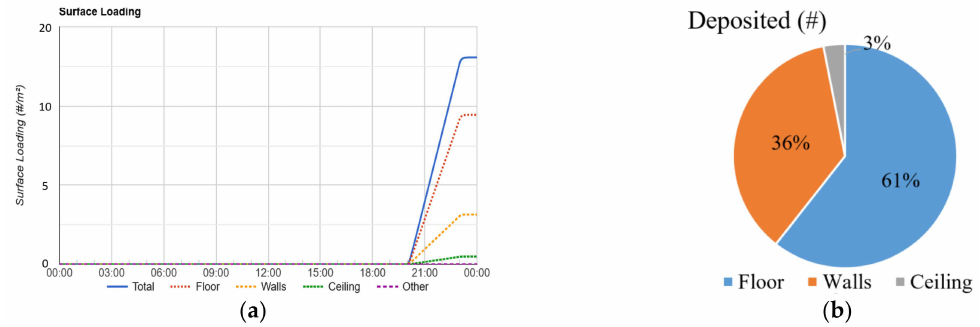
Figure A1. Aerosols deposited on the surfaces of the indoor space: ( a ) transient surface loading; ( b ) percentage of aerosols deposited on each surface.